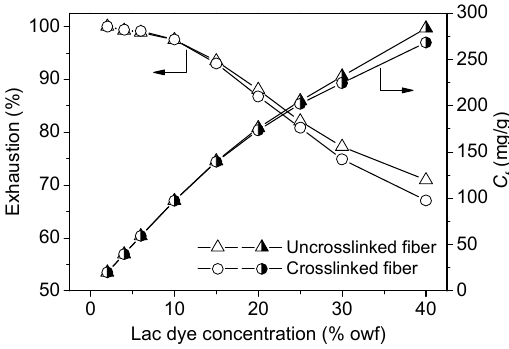
Figure 6. Building-up properties of lac dye for the uncrosslinked and crosslinked chitosan fibers.